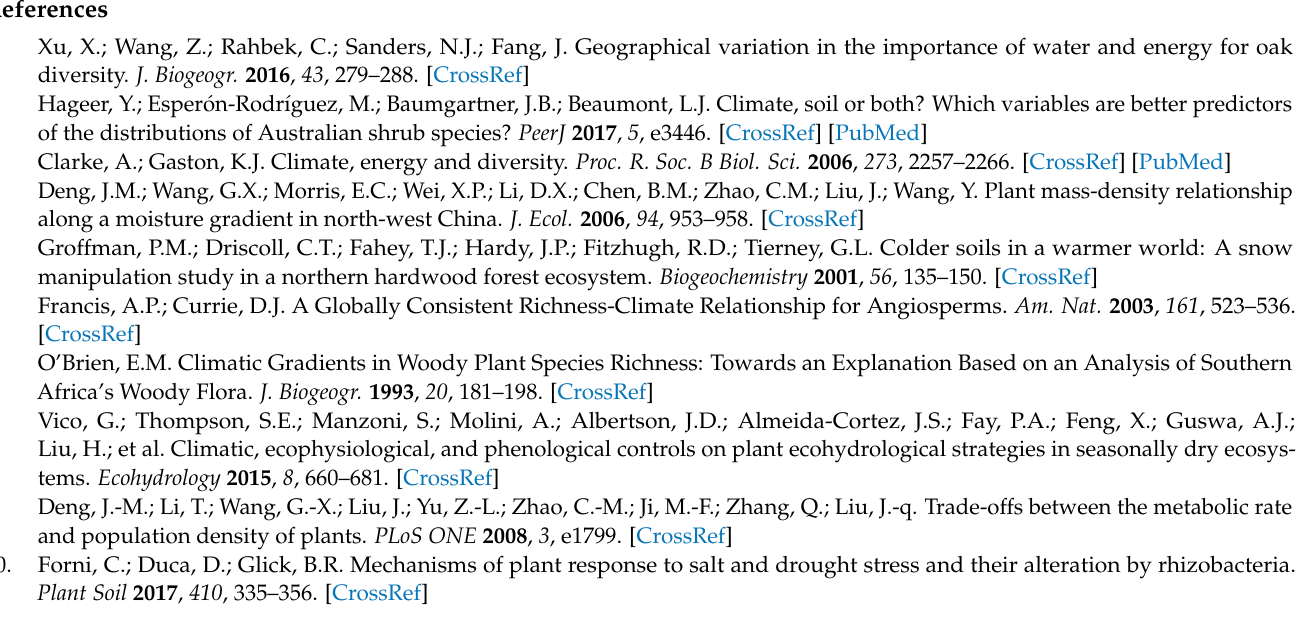
sites, Figure S1: The variation of water and energy effects on plant diversity for lifeforms by variation partitioning. The left value is the explained variability by the independent components of water, the middle value represents variability explained by the covarying component of water and energy, and the right value is the explained variability by the independent components of the environment. Residuals represent unexplained variability. All of the variation values were adjusted by coefficient of determination. In Figure S1b, NaN represents the only three sites for ephemeral plants in hyperarid regions, so it is not operable by variation